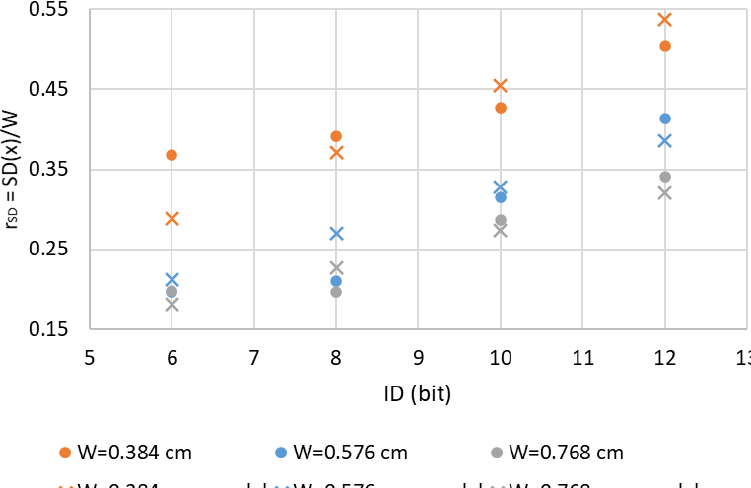
Figure 5. Circular Traveling Task: r SD vs. ID for different W values.